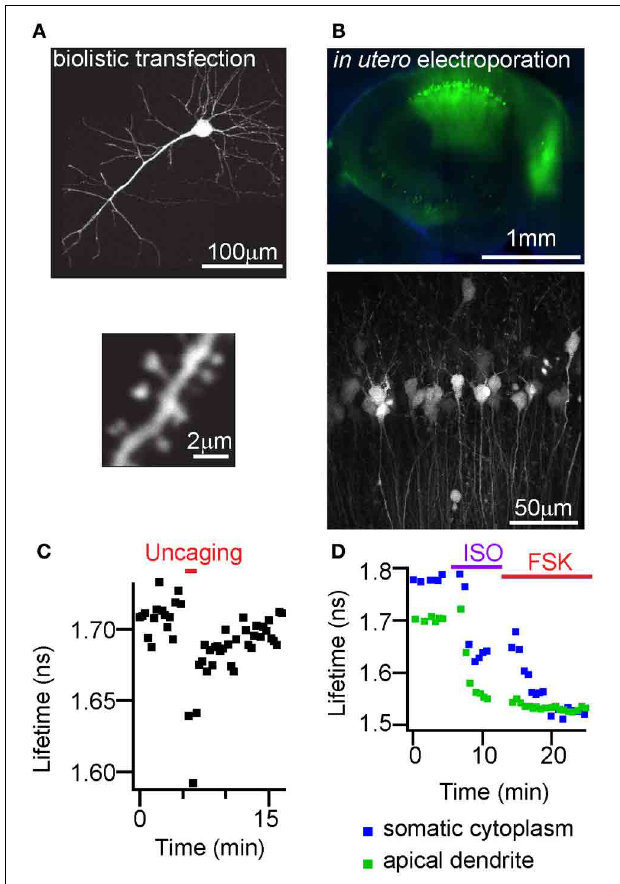
FIGURE 6 | FLIM-AKAR shows high expression with different transfection methods and lifetime responses to glutamate or GPCR activation in the hippocampus. (A) Images showing a hippocampal CA1 neuron (top), dendrite and spines (bottom) from an organotypic slice transfected with FLIM-AKAR with biolistic method. (B) Image showing a 300 μ m acute hippocampal slice expressing FLIM-AKAR in CA1 region after in utero electroporation. (C) Example plot of lifetime change of FLIM-AKAR in a stimulated spine in response to photolysis of caged glutamate adjacent to the spine. A CA1 pyramidal neuron in an organotypic hippocampal slice was biolistically transfected with FLIM-AKAR, and the stimulated spine shows enlargement following 2-photon photolysis of caged glutamate (MNI-glutamate). The temporal window of uncaging is indicated in the red bar above. (D) Lifetime response of FLIM-AKAR upon isoproterenol (1 μ M, ISO) treatment to activate β -adrenergic receptors followed by forskolin (50 μ M, FSK) treatment to activate adenylate cyclases. The experiment was done in acute hippocampal slice expressing FLIM-AKAR in CA1 region after in utero electroporation.